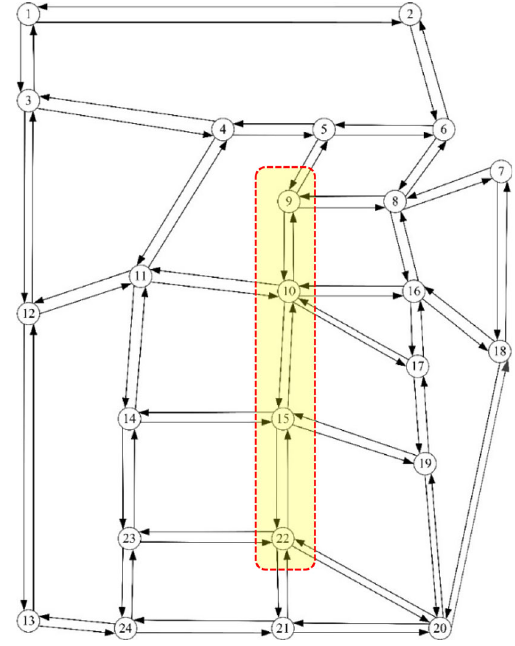
Fig. 4 Sioux Falls network and cordoned area